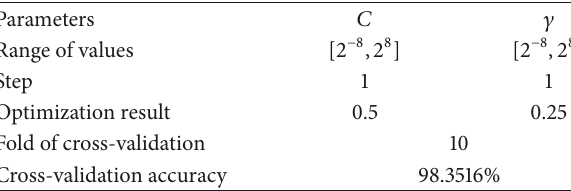
Table 2: Interval division of experimental data. Table 3: Parameters setting and optimization results of Grid